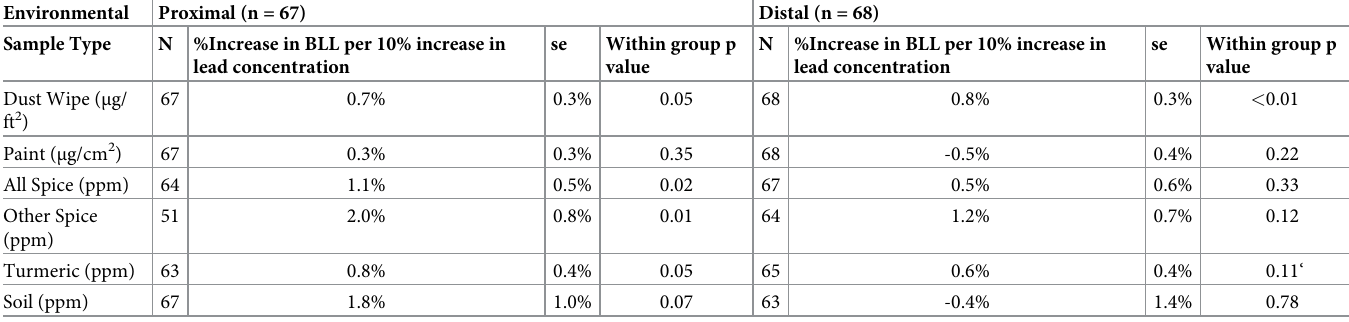
Table 8. Percent increase in BLL for every 10% increase in environmental lead levels in household samples stratified by distance to ULAB activities. Patna, Bihar February 2020. Environmental Proximal (n = 67)